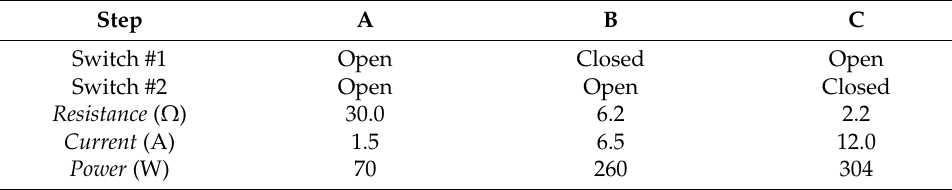
Figure 17. Configuration of the resistive load for testing the dynamic response. Table 2. Parameters and Switch Relay Conditions for Resistive Loads.